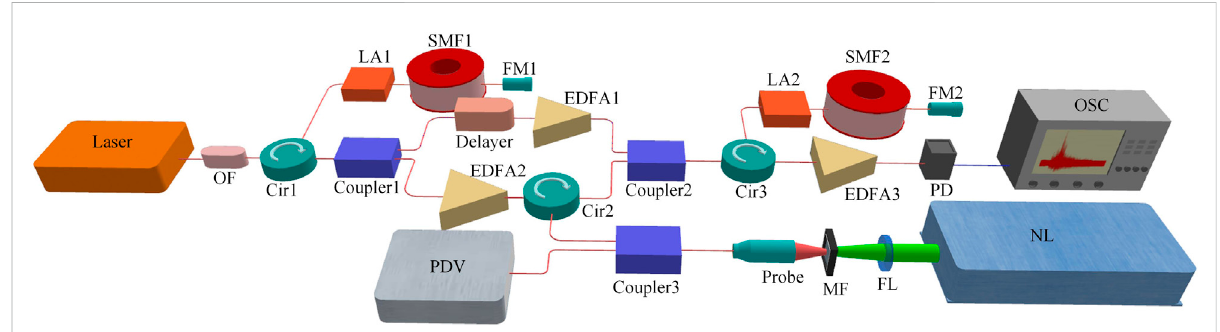
FIGURE 2 Simpli fi ed schematic of TS-PDV system. Laser: 50 MHz Mode-Locked Laser, OF: optical fi lter, Cir1, Cir2 and Cir3: three-port fi ber-optic circulator, RA1 and RA2: Raman Ampli fi er, SMF1 and SMF2: 100 km single mode fi ber, FM1 and FM2: fi ber mirror, Coupler1 and Coupler2: 90/10 and 50/50, EDFA1, EDFA2 and EDFA3: doped fi ber ampli fi er, Probe: fi ber focus lens, MF: metal fi lm, FL: focus lens, NL: nanosecond laser, PD: photoelectric detector, OSC: DSA91304 KEYSIGHT, bandwidth 13 GHz and sampling frequency 40 GSa/s